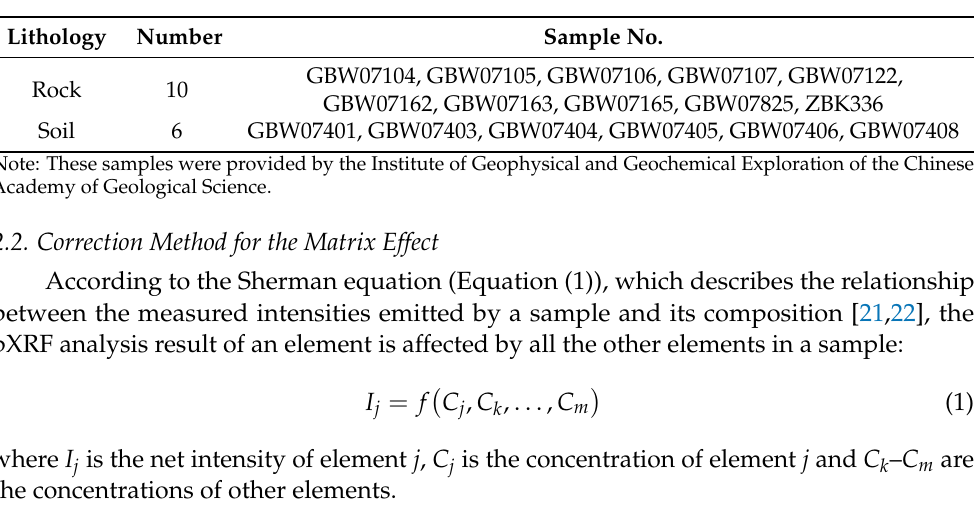
Table 1. Certified reference samples for pXRF